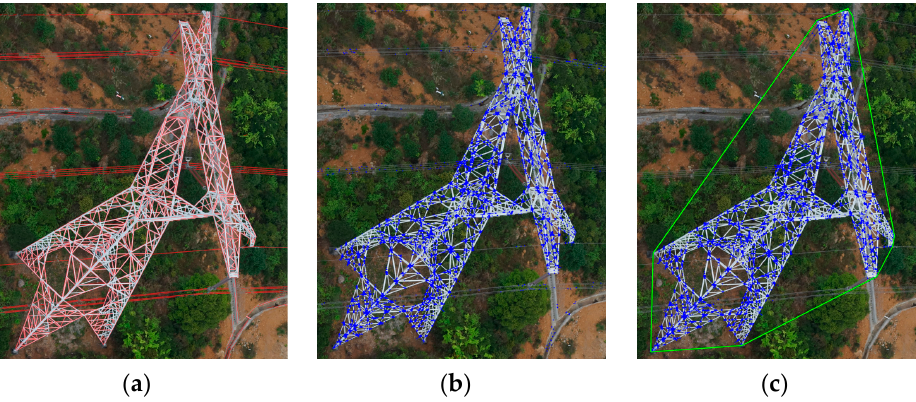
Figure 6. The results of intersection point computation and clustering ( a – c